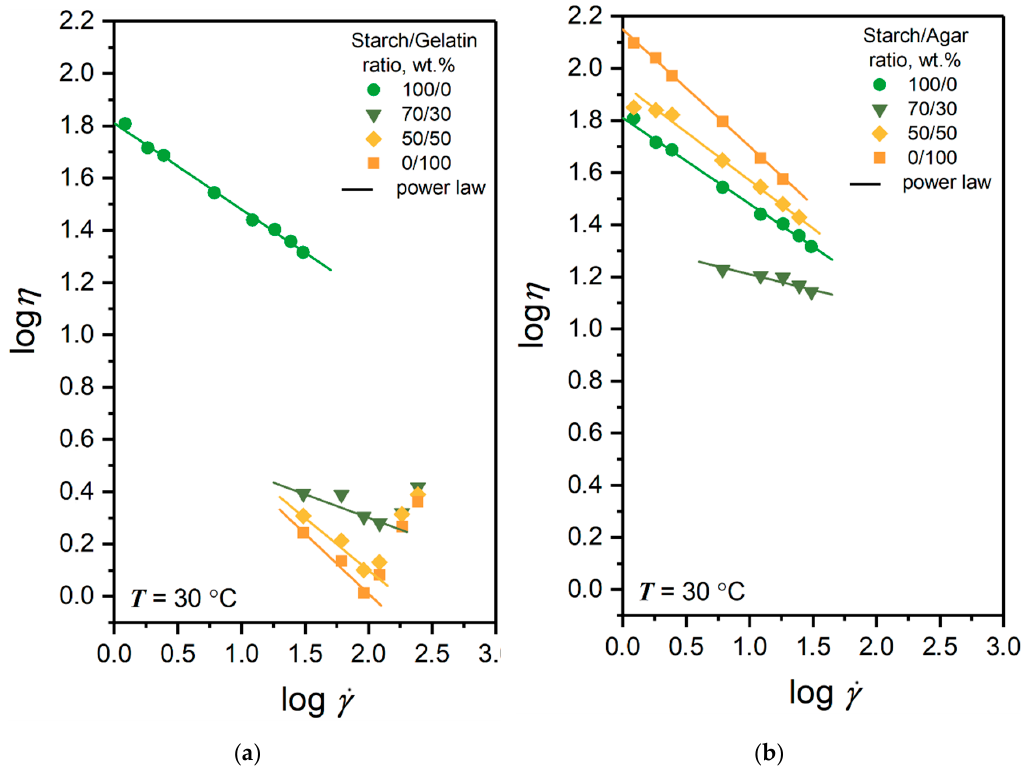
Figure 2. Flow curves of the film-forming solution of ( a ) potato starch, gelatin and their blends and ( b ) potato starch, agar and their blends at a temperature of 30 °C.